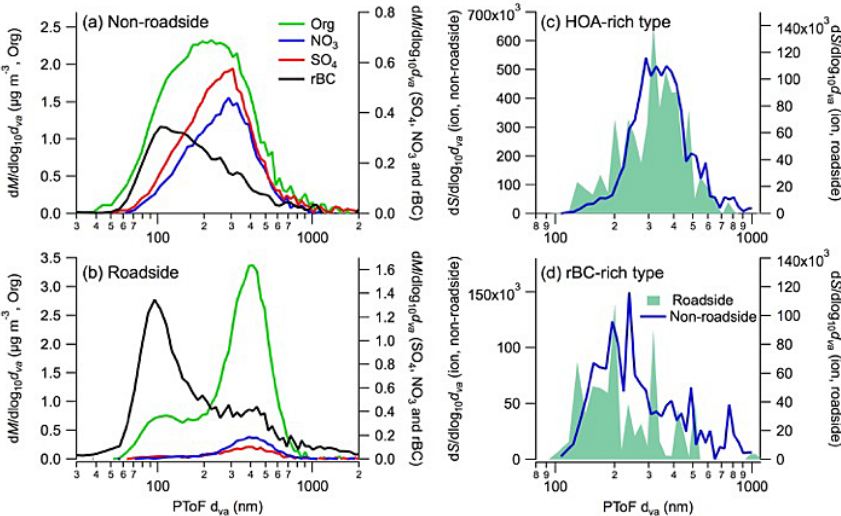
Figure 2. Particle size distributions from the non-roadside and roadside studies: (a) mass-based ensemble size distribution of refractory black carbon (rBC, black), organic species (Org, green), sulphate (SO 4 , red), and nitrate (NO 3 , blue) for the non-roadside study; (b) mass-based ensemble size distribution from the roadside study; (c) ion-signal-based single particle size distributions for HOA-rich particle classes from the roadside (filled green) and non-roadside (blue) studies; (d) ion-signal-based single particle size distributions for rBC-rich particle classes from the roadside (filled green) and non-roadside (blue) studies. The SP-AMS measured rBC-containing particles only during the roadside study, while both rBC-containing and non-rBC-containing particles were measured in the non-roadside